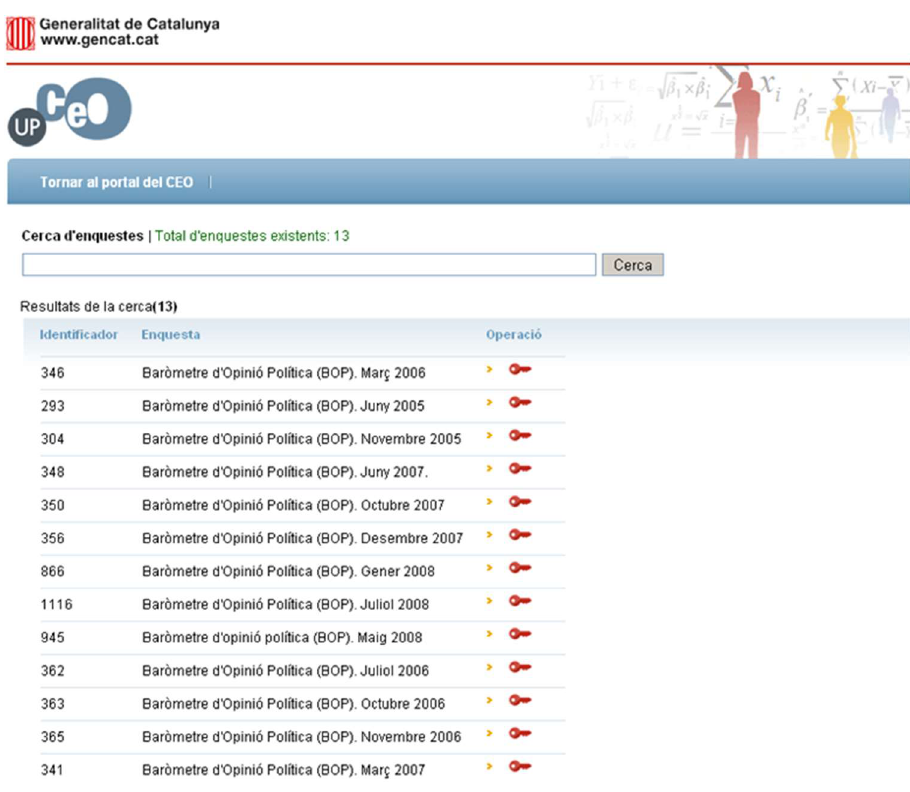
Figure 10. Selection of the matrix.